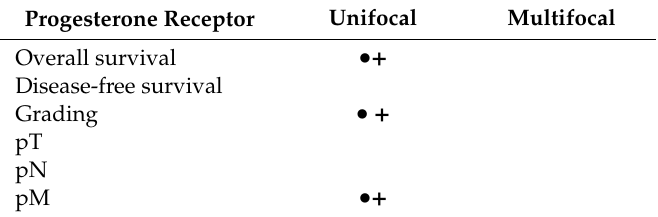
Table 3. Significant results for the progesterone receptor-positive patients.